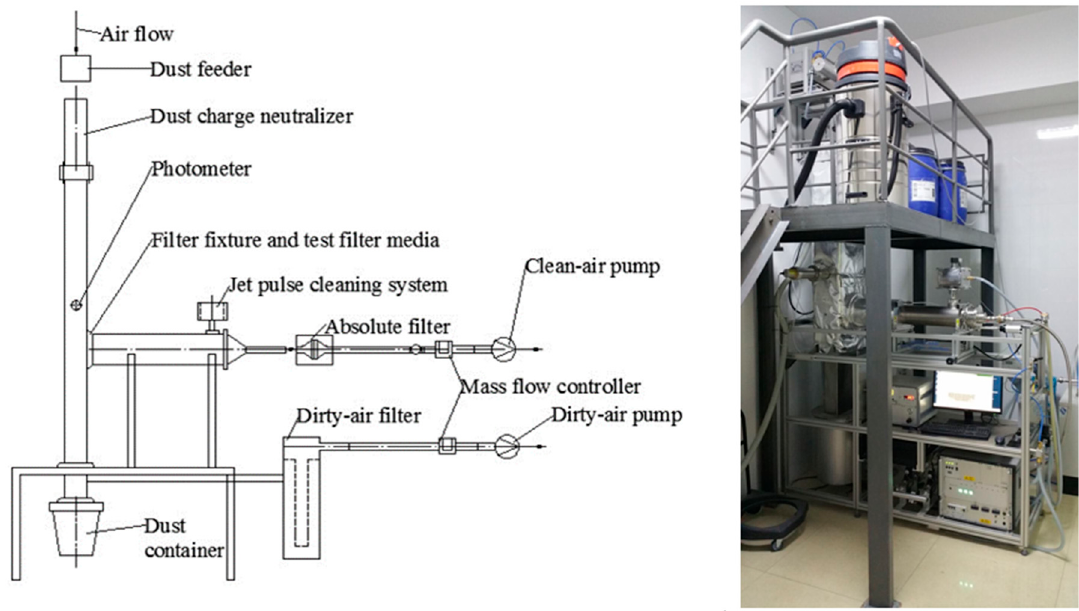
Figure 3. An experimental device was used to determine the dynamic filtration performance of a filter media.